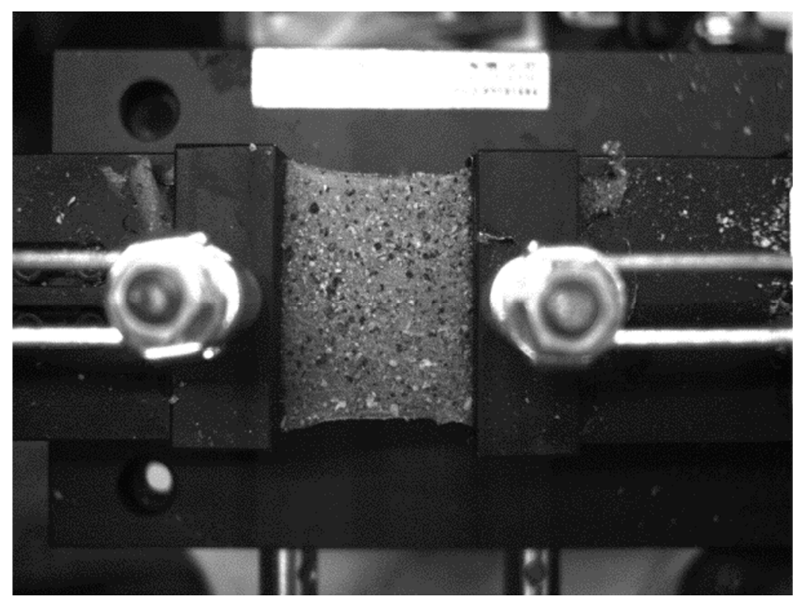
Figure 7. Image of white spot markers randomly sprayed on the chicken breast bio-tissue sample.